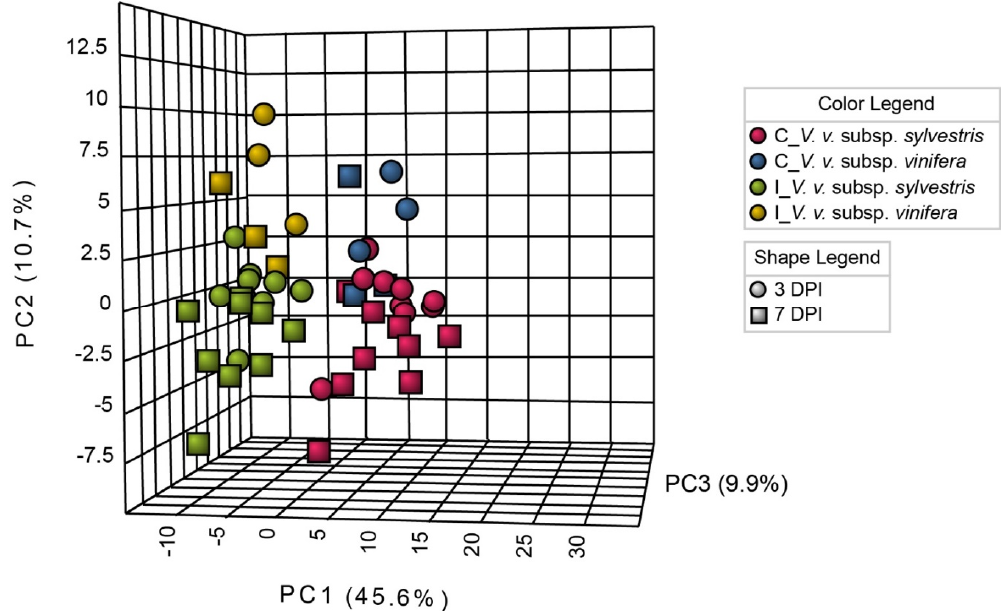
Figure 4. Three-dimensional principal component analysis (3D-PCA) of specialized metabolite contents. PCA was performed on mean values of the three biological replicates at three and seven days post-inoculation (DPI). The value of each biological replicate was normalized to T0 value in non-inoculated sample. Control samples (C) were inoculated with PDA, inoculated samples (I) were inoculated with N. parvum . Each time point is represented by a symbol (dots for three DPI and rectangles for seven DPI). The V. v. subsp . sylvestris and V. v. subsp . vinifera genotypes are represented by different colors (red for V. v. subsp . sylvestris and blue for V. v. subsp . vinifera for C samples and green for V. v. subsp . sylvestris and yellow for V. v. subsp . vinifera for I samples). The three major principal components explained 66.2% of the cumulative variance.